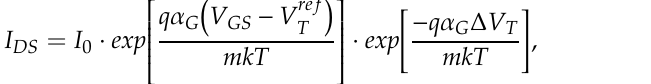
Figure 5. Schematic of memory arrays based on ( a ) NAND Flash and ( b ) NOR Flash architecture.